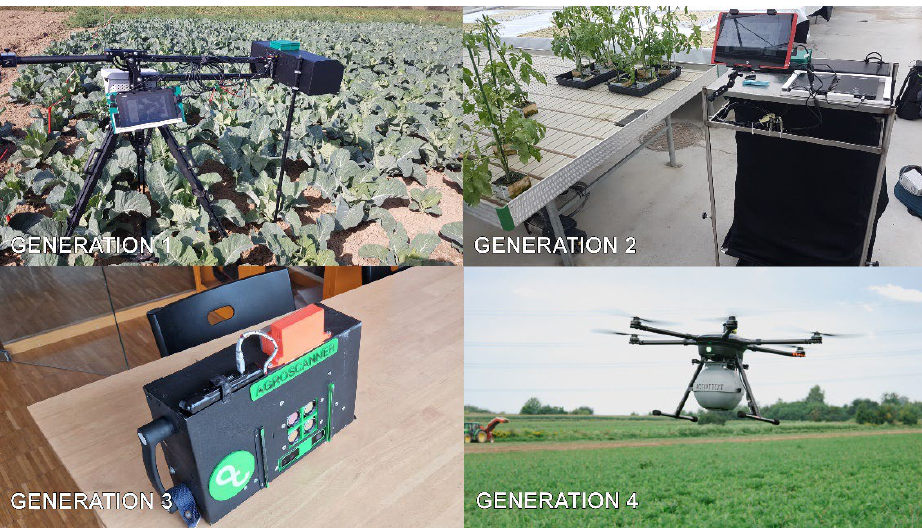
Figure 1. Agroscanner generations created during the research project.